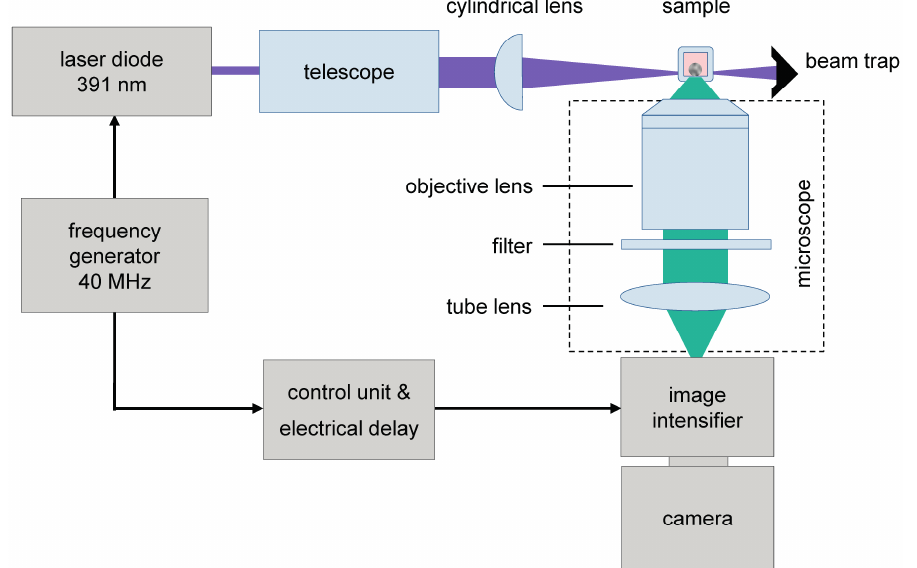
Figure 8. Fluorescence lifetime imaging (FLIM) using a light sheet based fluorescence microscope. Picosecond laser pulses and time-gated image detection are synchronized at a frequency of 40 MHz. All images are integrated over a period of 4